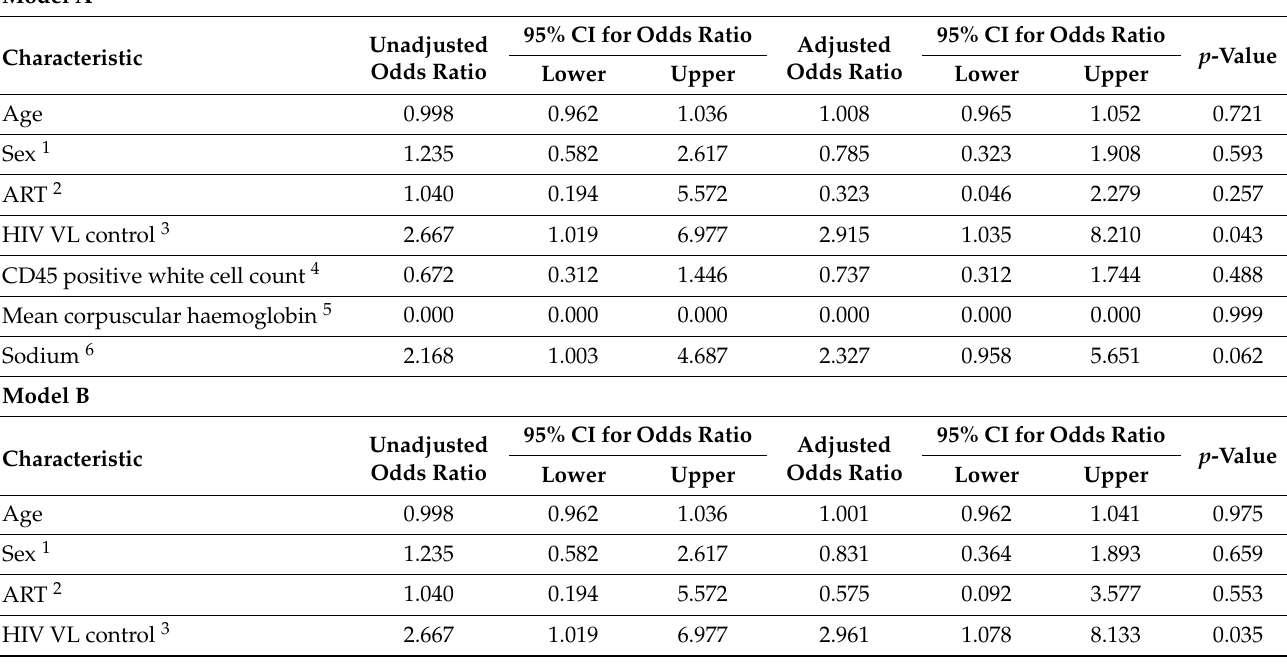
Table 3. Logistic regression for SARS-CoV-2 antibody response in HIV positive patients ( n = 150). Model A includes biologically relevant demographic and clinical parameters as well as relevant parameters found to be associated with SARS-CoV-2 antibody response on a univariate level (see Table 2). Model B excludes parameters that were not significant in Model